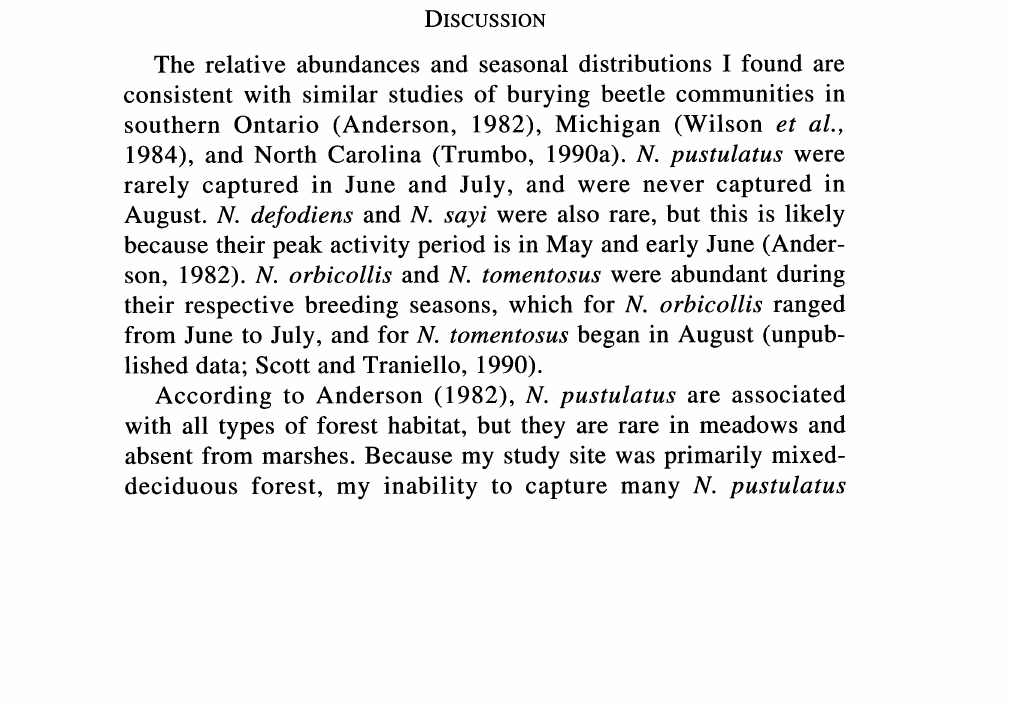
Figure 2. Relationship between carcass mass and total brood mass for N. pustula- tus (filled circles) and N. orbicollis (open circles).